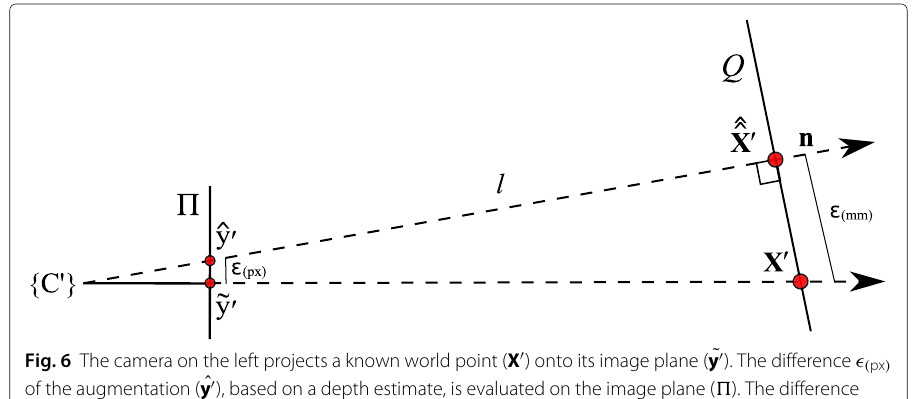
Fig. 6 The camera on the left projects a known world point ( X (cid:3) ) onto its image plane ( ˜ y (cid:3) ). The difference (cid:3) ( px ) of the augmentation ( ˆ y (cid:3) ), based on a depth estimate, is evaluated on the image plane ( (cid:2) ). The difference ˆ ˆ (cid:3) (cid:3) ( X ) is evaluated on a target plane ( Q ), given in world units (mm) mm ) of its reprojection (